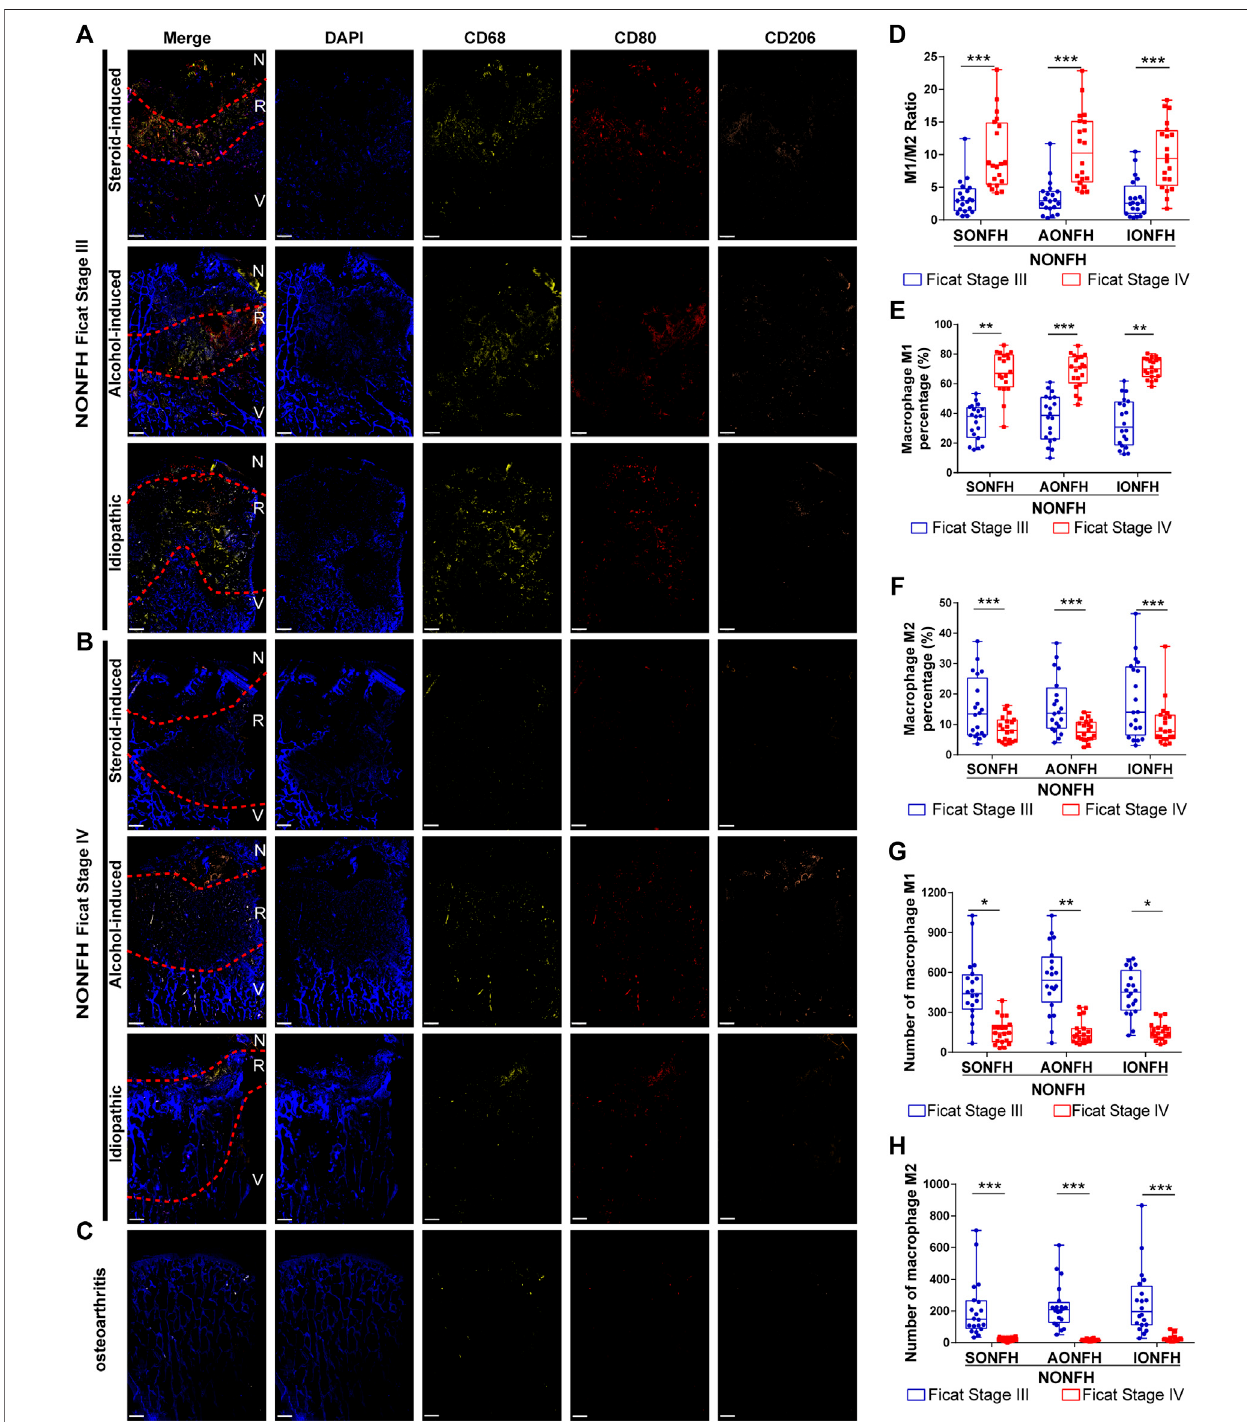
FIGURE 2 | Macrophage M1/M2 imbalance increased from progressive-stage to end-stage NONFH (A,B) Representative mIHC images of M1 (CD68 + CD80 + CD206 - )andM2(CD68 + CD80 − CD206 + )macrophagesinsectionsfrompatientswithdifferenttypesNONFHinthe (A) progressivestageor (B) end-stage. Scale bar, 2 μ m (C) Representative mIHC images of M1 and M2 macrophages in patients with osteoarthritis. Scale bar, 2 μ m (D) Comparison of M1/M2 macrophage ratiosinpatientswithdifferenttypesandstagesofNONFH (E,F) Comparisonofthepercentagesof (E) M1and (F) M2macrophagesinpatientswithdifferenttypes andstagesofNONFH (G,H) Comparisonofthenumbersof (G) M1and (H) M2macrophagesinpatientswithdifferenttypesandstagesofNONFH.* p < 0.05;** p < 0.01; *** p < 0.001.